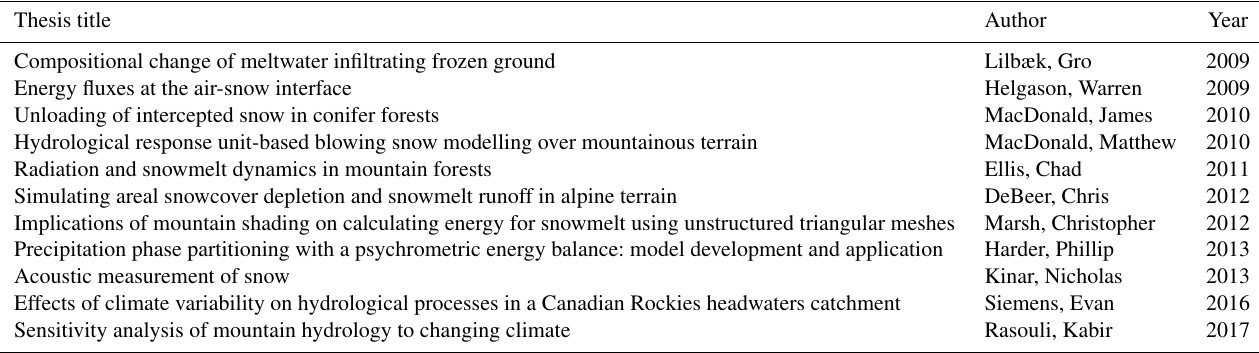
Table 7. Marmot Creek Research Basin theses in chronological order for the recent